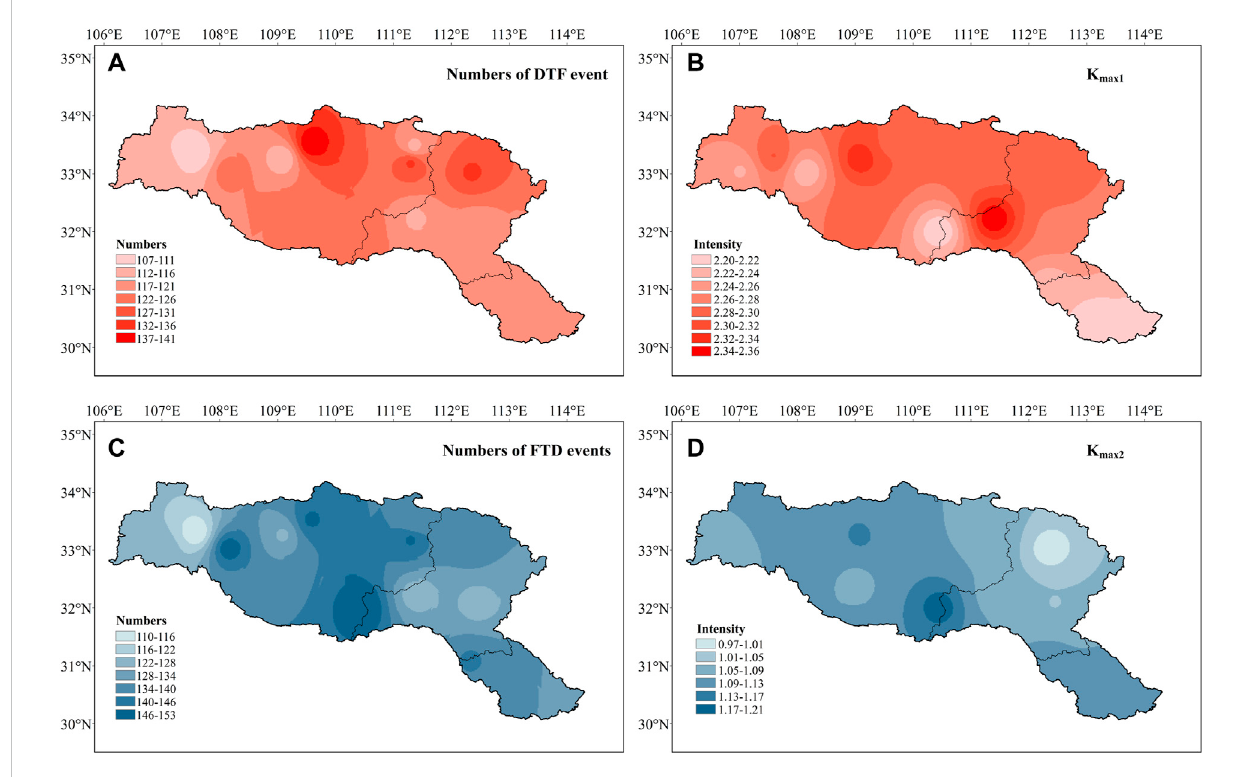
FIGURE 5 SpatialinterpolationsofDFAAcharacteristicsintheHRBbetween1961and2020: (A) numberofDTFevents, (B) K max1 , (C) numberofFTDevents,and (D) K max2